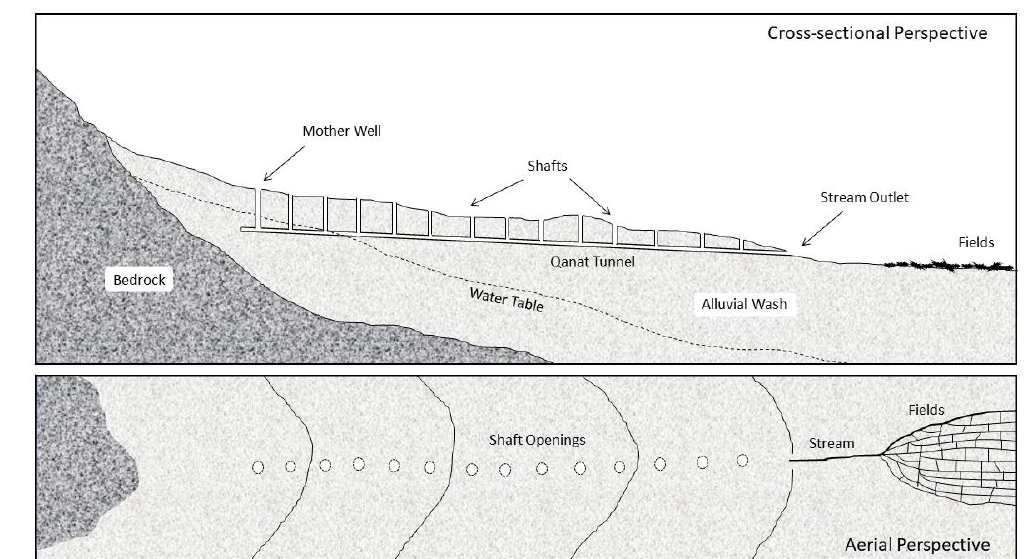
Figure 1. Stylized view of a typical qanat. The cross-sectional perspective shows the relationship of the tunnel to the water table and other subsurface features, as well as to the agricultural fields. The aerial perspective shows the typical pattern of surface openings above the channel and the pathway to the fields. The curved lines from left to right indicate decreases in elevation. After illustrations by Beaumont [60] and English [63].